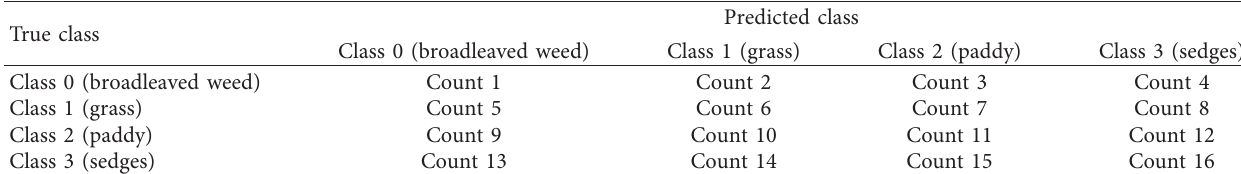
Table 4: Confusion matrix for the multiclass classification problem.